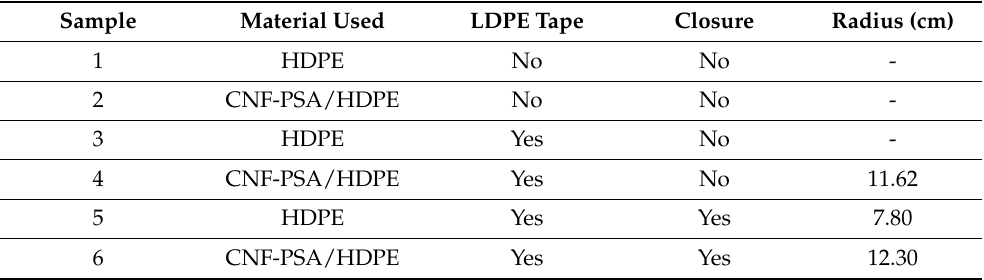
Table 2. Summary of warping measurements of HDPE and composite of 10 wt.% of CNF PSA/HDPE in the full model.